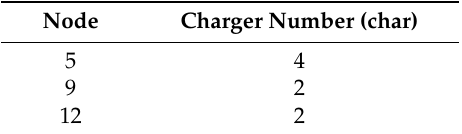
Table 7. Charging station construction program.